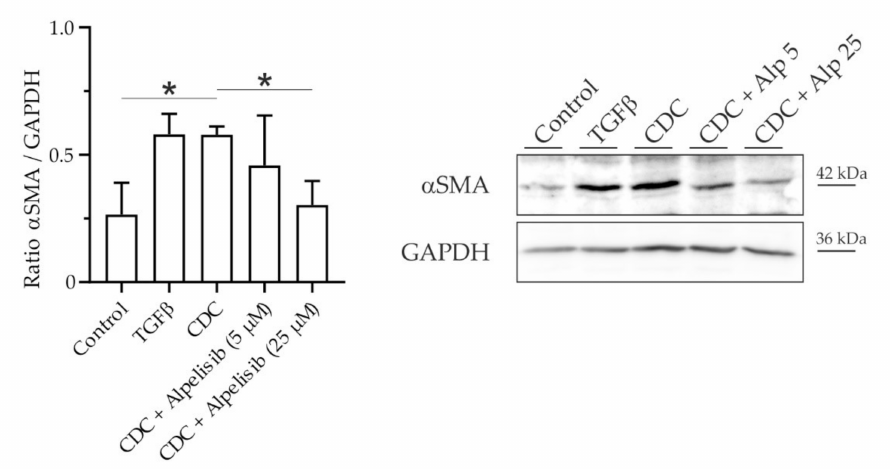
Figure 4. CDC-induced activation of the HSC cell line LX-2 is reduced by the PI3K p110 α -specific inhibitor Alpelisib. The human HSC cell line LX-2 was incubated with CDC (20 µ M) in the pres- ence or absence of Alpelisib (Alp, 5 and 25 µ M) for 24 h. The control was treated with diluent (0.1% dimethyl sulfoxide). TGF- β 1 (10 ng/mL) served as a positive control for activation of LX-2 cells. α SMA protein expression was determined by Western blotting ( n = 4) and normalized to GAPDH. Results are shown as mean ± SD (* p < 0.05 vs. control or co-incubation with Alpelisib 25 µ M, Tukey